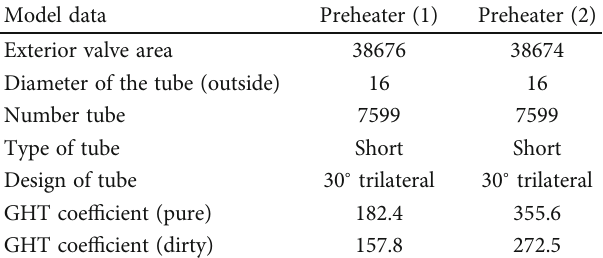
Table 2: Preheater model data.